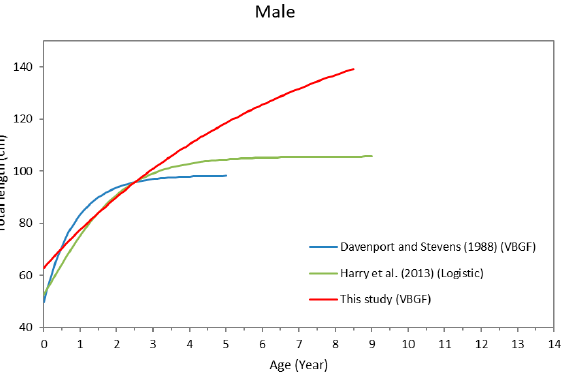
Figure 8. Comparison of the growth curves of male spot-tail sharks in different regions. VBGF: Davenport and Stevens (1988), and this study; Robertson: Harry et al. (2013).